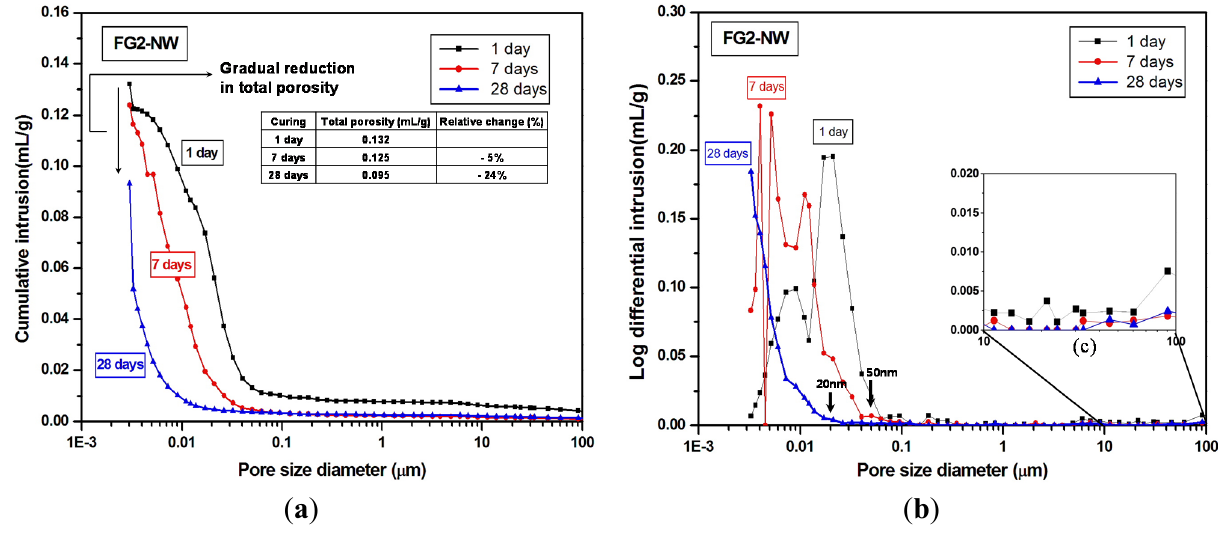
Figure 2. Pore size distribution curves of the F-NW samples (case of no gypsum addition) after one, seven, and 28 days of curing. ( a ) cumulative distribution; ( b ) log differential distribution; ( c ) a magnified plot for 10 to 100 μ m pores, which are visible in the SEM images of the later section.